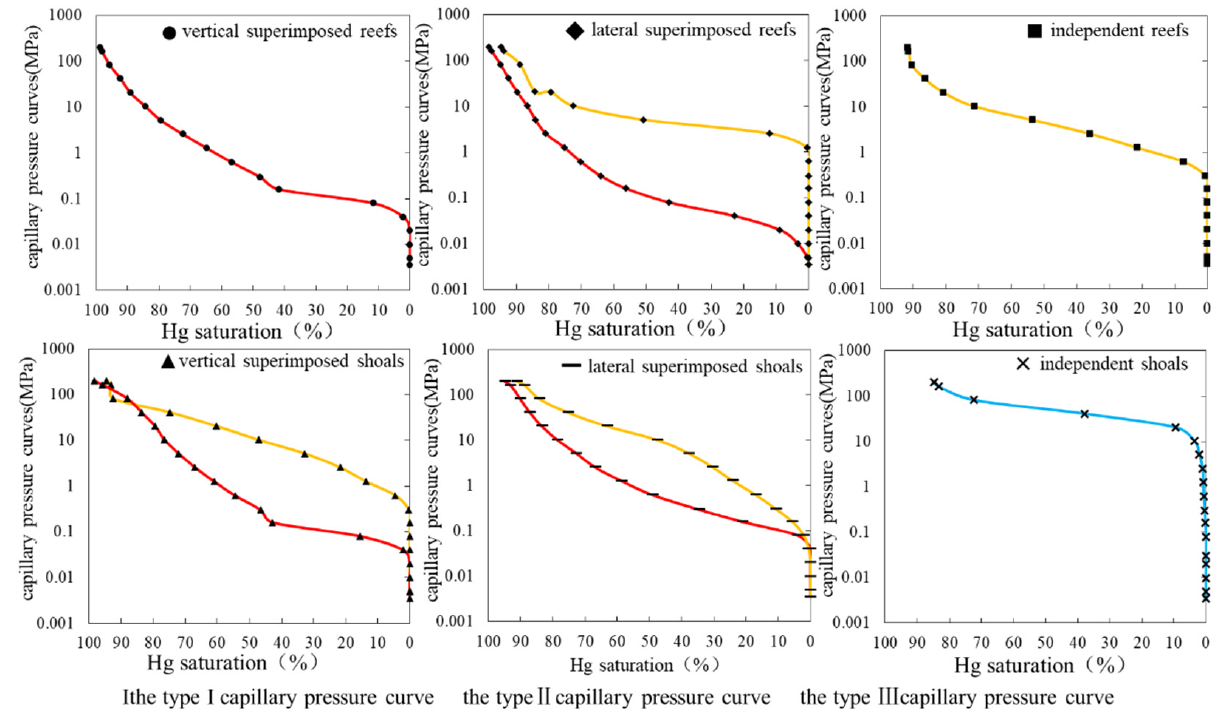
Figure 10. Capillary pressure curve characteristics of various architecture types.